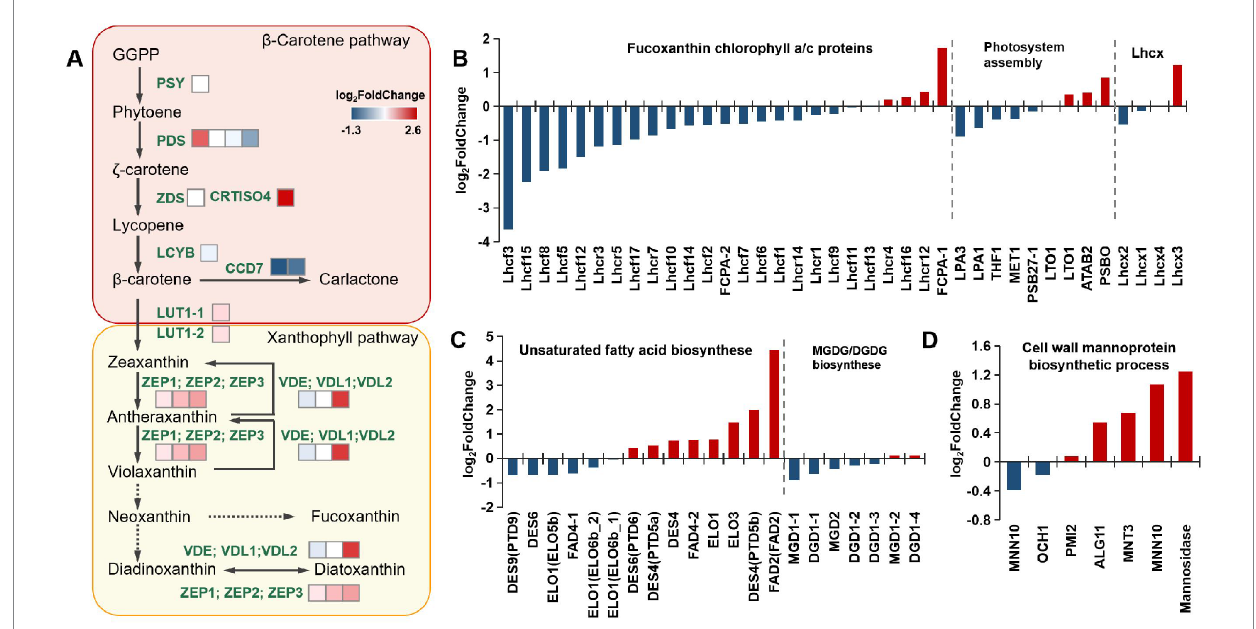
FIGURE 5 Transcriptomic analysis of different metabolic pathways. (A) Expression of genes in the carotenoid synthesis pathway. (B) Expression of genes in the FCP complex, photosystem assembly, and the Lhcx genes. (C) Expression of genes in the polyunsaturated fatty acid synthesis pathway and MGDG/ DGDG synthesis pathway. (D) The mannose metabolism genes are related to cell wall synthesis. All abbreviations and data are provided in Supplementary Data 2.